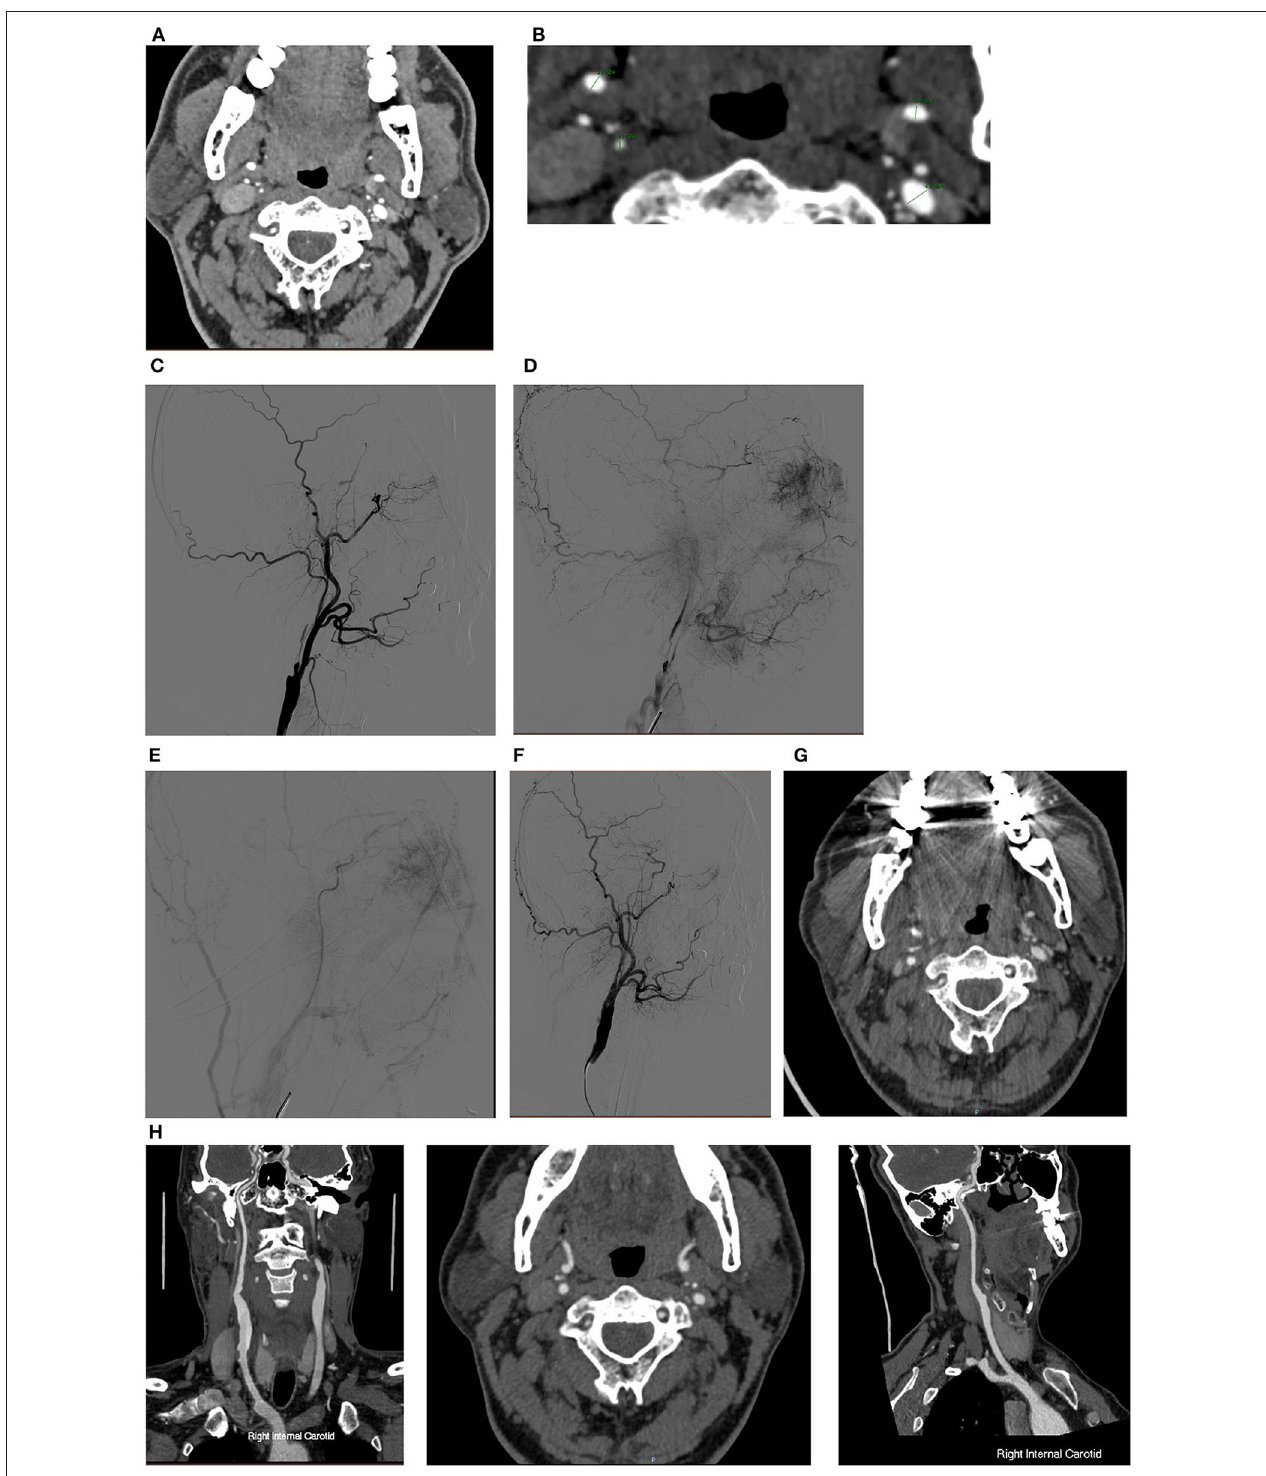
FIGURE 1 | A typical case of CEA for CNO with distal full collapse. (A,B) CTA characteristics for CNO with distal collapse. Right ICA: 1.51mm, right ECA: 2.86mm, left ICA: 2.69mm, left ECA: 4.31mm, right ICA/left ICA: 0.56 ( ≤ 0.87), right ICA/ECA: 0.53 ( ≤ 1.27); DSA characteristics for CNO with distal collapse. (C) Severe stenosis of the ICA with a collapsed distal ICA; (D) delayed time of contrast arrival of distal ICA; (E) delayed antegrade flow of the patent ICA in the late arterial phase; (F) consistent contrast arrival of ICA and ECA after CEA. The 30-day and 12-month CTA follow-up showed the RICA is patent. (G) Axial and sagittal view of 30-day CTA; (H) axial and sagittal view of 12-month